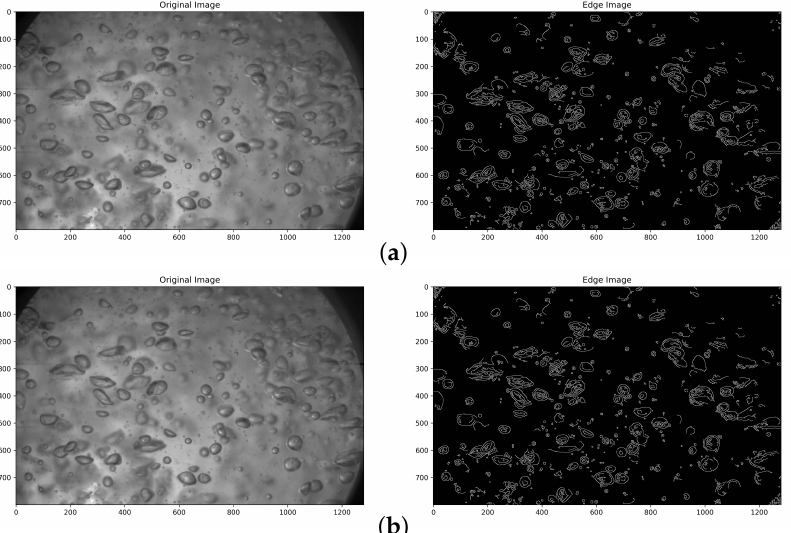
Figure 4. Examples of ( a ) Canny filter and ( b ) Frangi filter applied on a sample frame from the F3 video. One can see that the Canny filter produces more false edges while Frangi filter’s edges are wide which is not an easement for the following analysis. For the final methodology we have used both, namely Canny filter after Frangi filter, in order to make edges thinner while keeping in mind this approach might result in